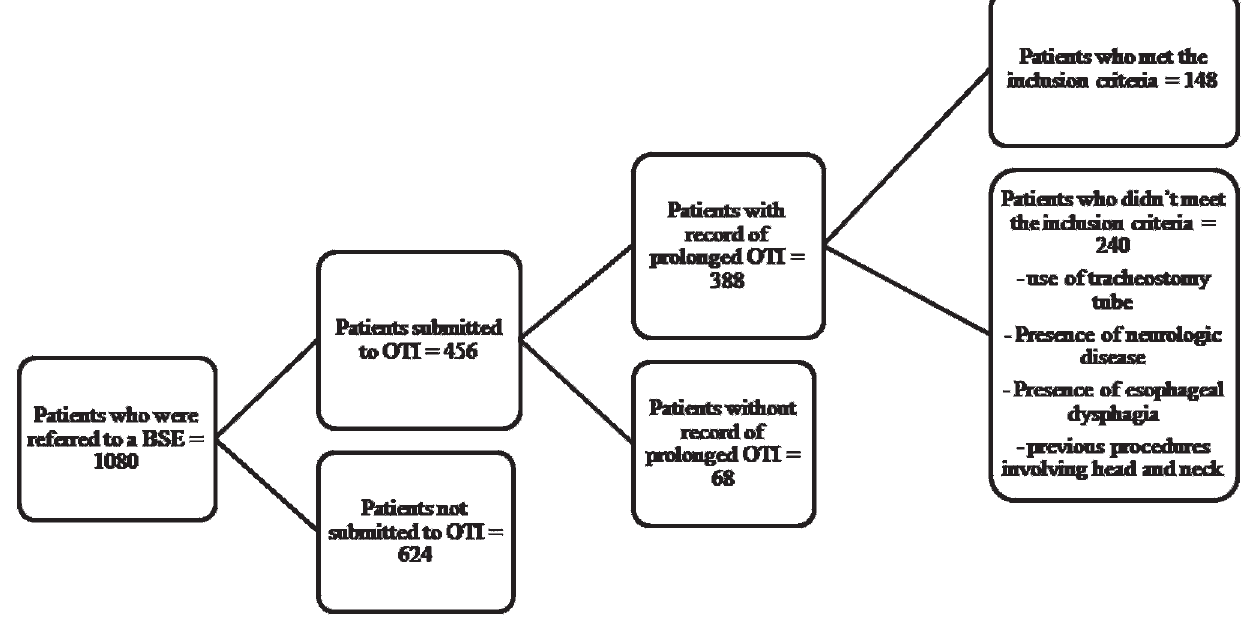
Figure 1 - The patient